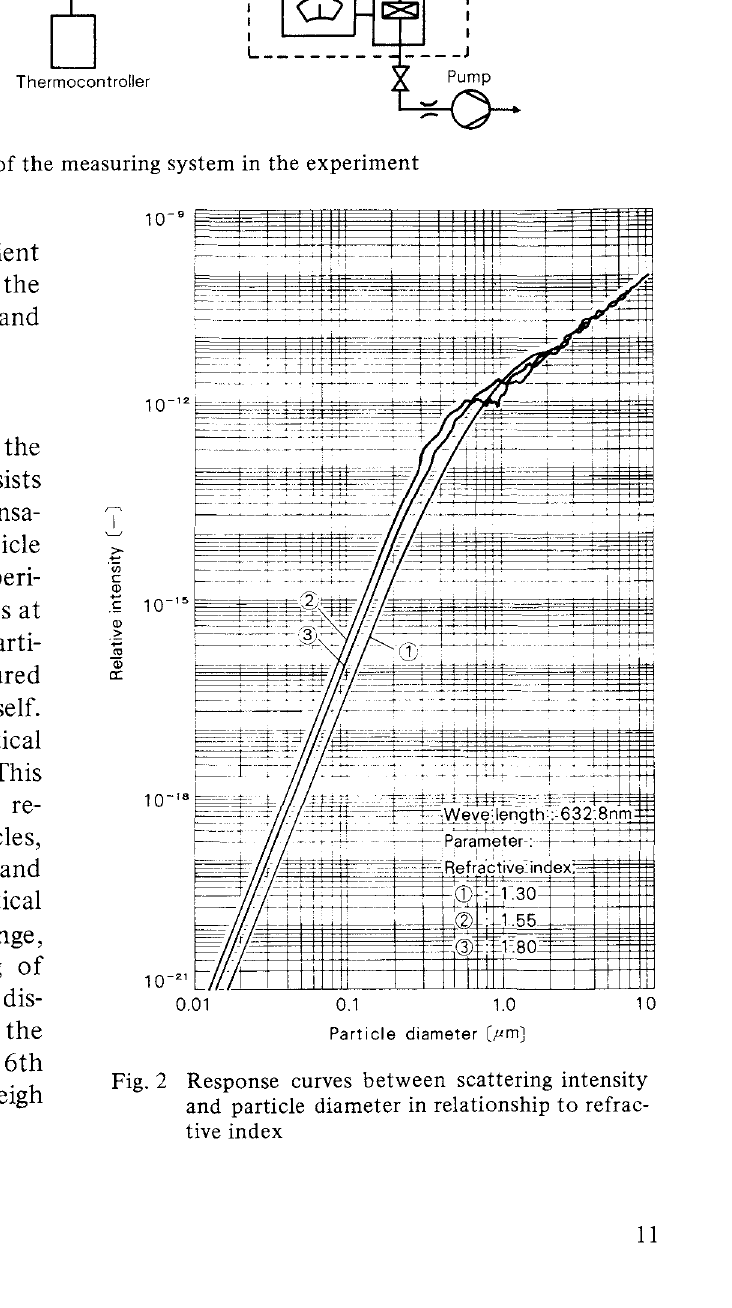
Fig. 2 Response curves between scattering intensity and particle diameter in relationship to refrac tive